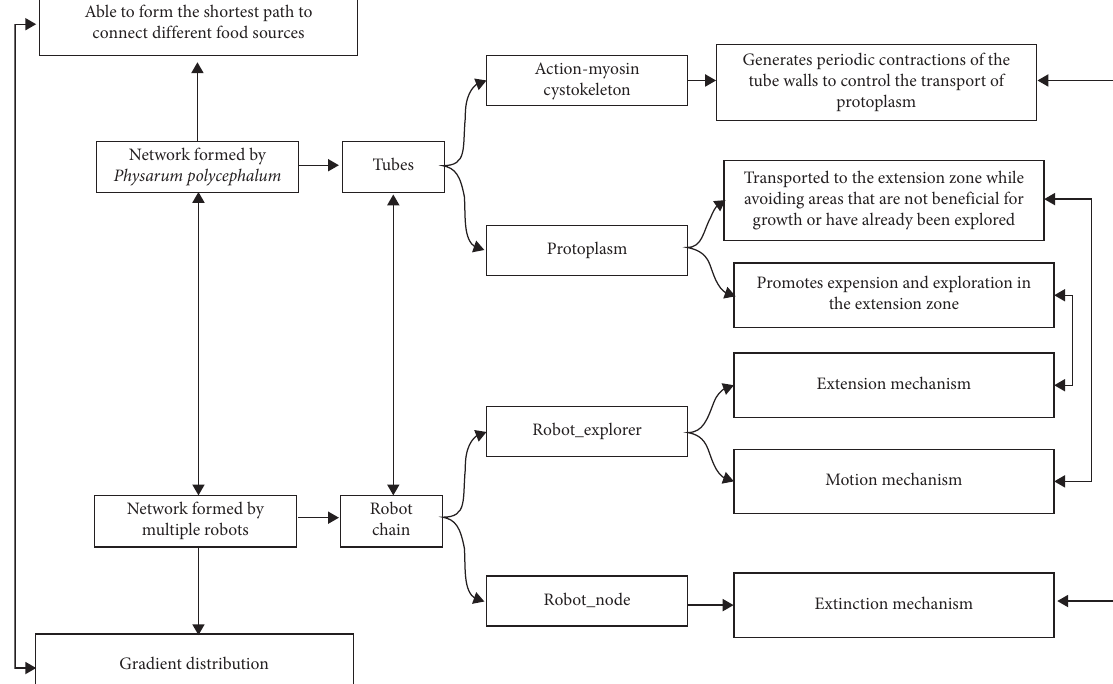
Figure 4: The mapping relationship between our controller and the foraging principle of Physarum polycephalum . Double arrows indicate